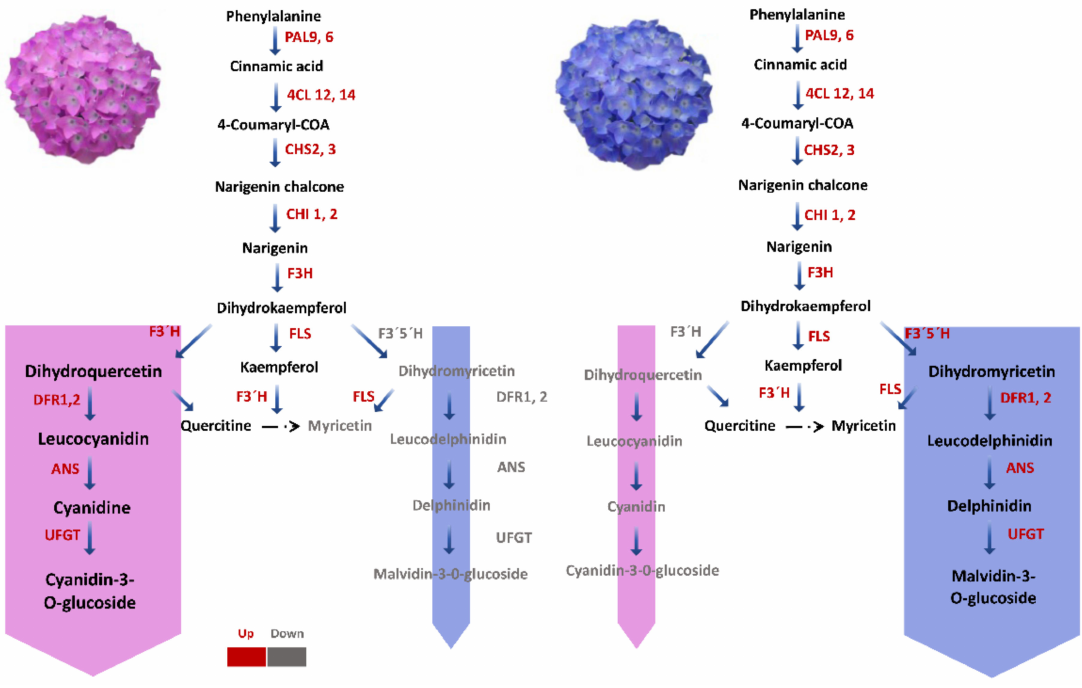
Figure 9. Key pathways for Hydrangea macrophylla flower expressions. Flavonoid biosynthetic path- ways are shown in treated and untreated hydrangea. Expression of F3 (cid:48) 5 (cid:48) H , F3 (cid:48) H , and F3H/FLS transcripts may lead to an increase in kaempferol and myricetin, further reducing anthocyanin production. In Al 3+ -treated plants, DFR expression combined with UFGT availability may stimulate anthocyanin synthesis, resulting in the formation of a blue colour. Phenylalanine ammonia lyase ( PAL ), 4-coumarate CoA ligase ( 4CL ), chalcone synthase ( CHS ), chalcone isomerase ( CHI ), flavanone 3-hydroxylase ( F3H ), flavonoid 3 (cid:48) ,5 (cid:48) -hydroxylase ( F3 (cid:48) 5 (cid:48) H ), dihydroflavonol 4-reductase ( DFR ), an- thocyanin synthase ( ANS ). Blue and purple boxes mark anthocyanin compounds present in each flower